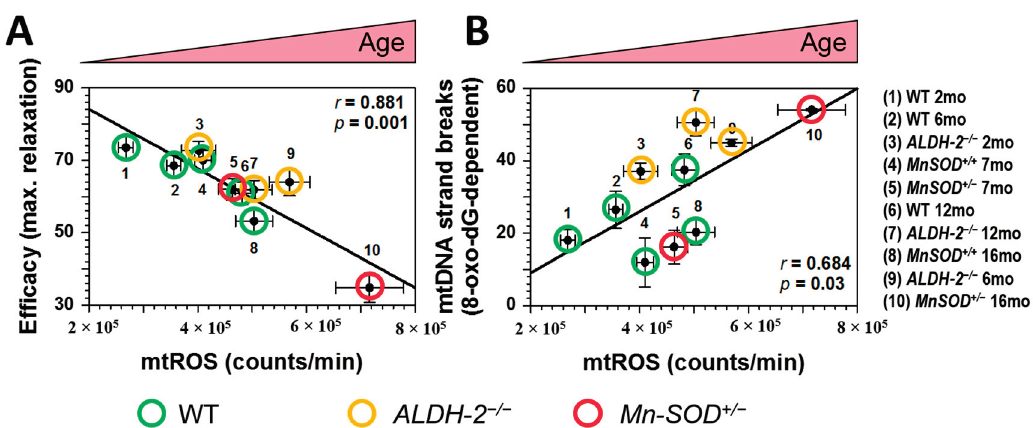
Figure 2. Correlations between mitochondrial oxidative stress (mtROS), mitochondrial DNA (mtDNA) damage and vascular (endothelial) function (ACh-induced maximal relaxation). ( A ) mtROS formation was plotted for all age-groups and mouse strains versus the corresponding maximal efficacy in response to acetylcholine (ACh); ( B ) mtROS was plotted for all age-groups and mouse strains versus the corresponding mtDNA damage. ROS were measured using L-012 (100 µM) enhanced chemiluminescence in isolated cardiac mitochondria upon stimulation with succinate (5 mM). r is the correlation coefficient. The groups are: 1 = B6 WT, 2mo; 2 = B6 WT, 6mo; 3 = ALDH-2 − / − , 2mo; 4 = MnSOD +/+ , 7mo; 5 = MnSOD +/ − , 7mo; 6 = WT B6, 12mo; 7 = ALDH-2 − / − , 12mo; 8 = MnSOD +/+ , 16mo; 9 = ALDH-2 − / − , 6mo; 10 = MnSOD +/ − , 16mo. The age of measured groups increases from the left to the right. Adopted from Wenzel et al. , Cardiovasc. Res . 2008 [23]. With permission of the European Society of Cardiology. All rights reserved. © The Author and Oxford University Press